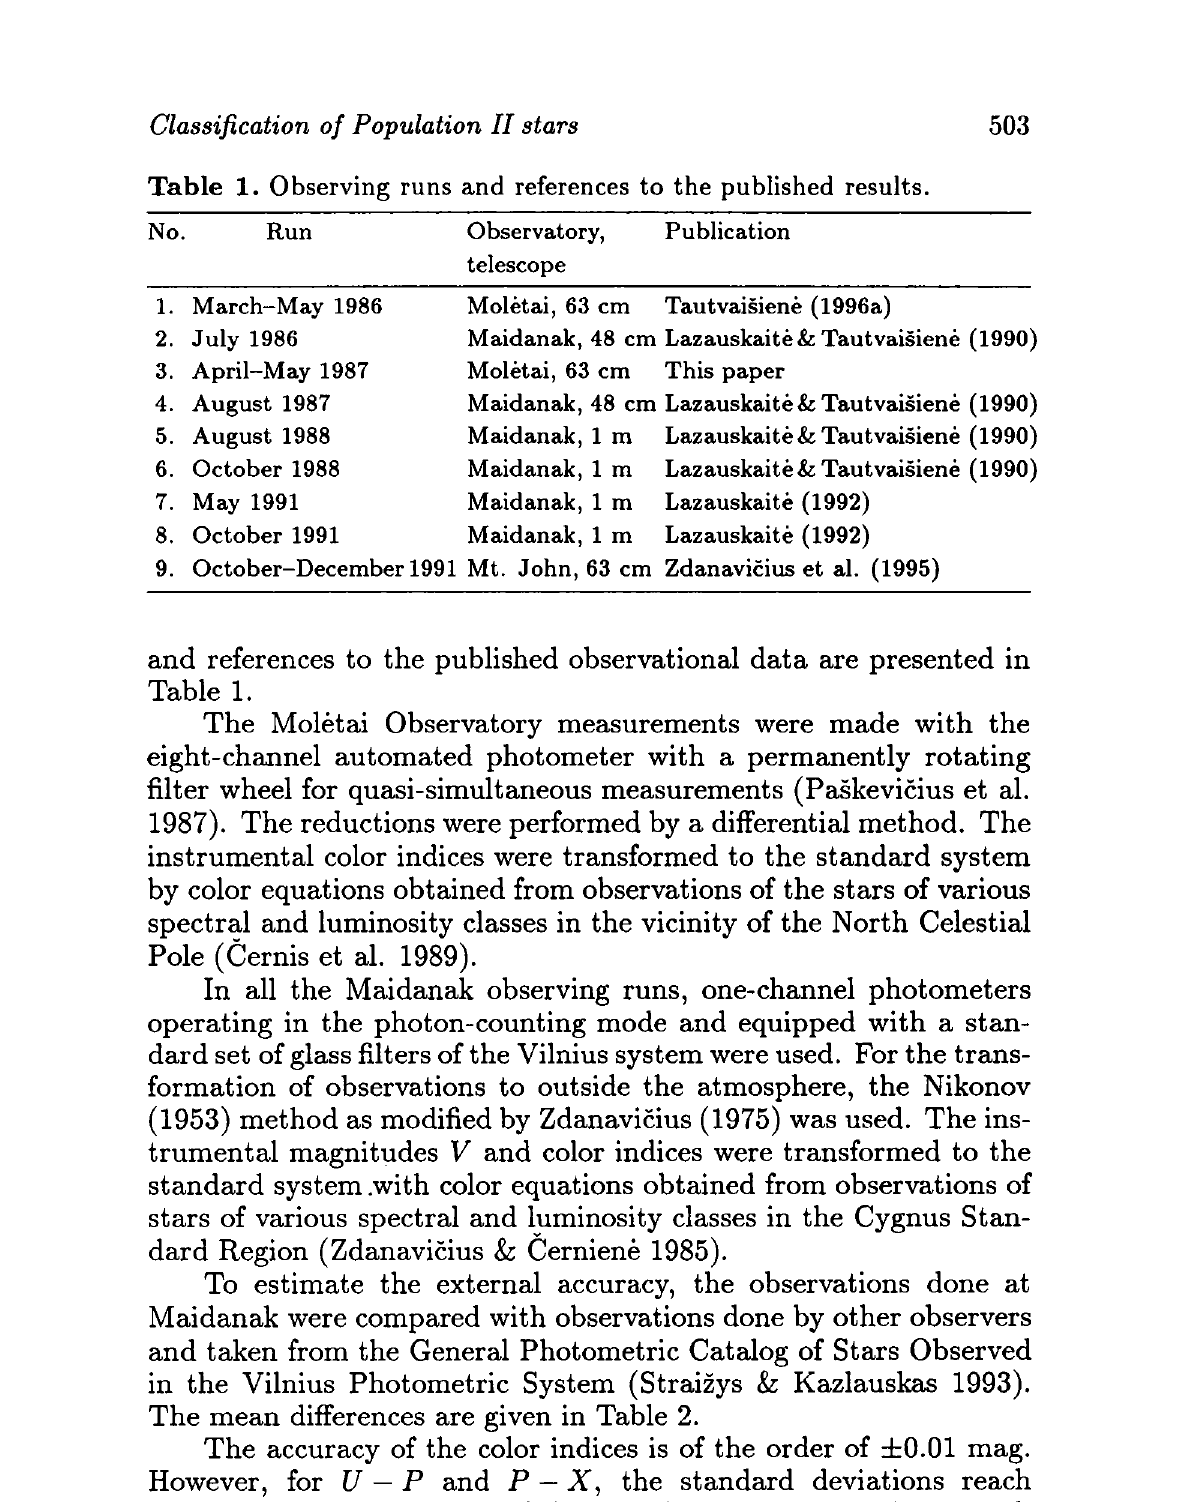
Table 1. Observing runs and references to the published results.